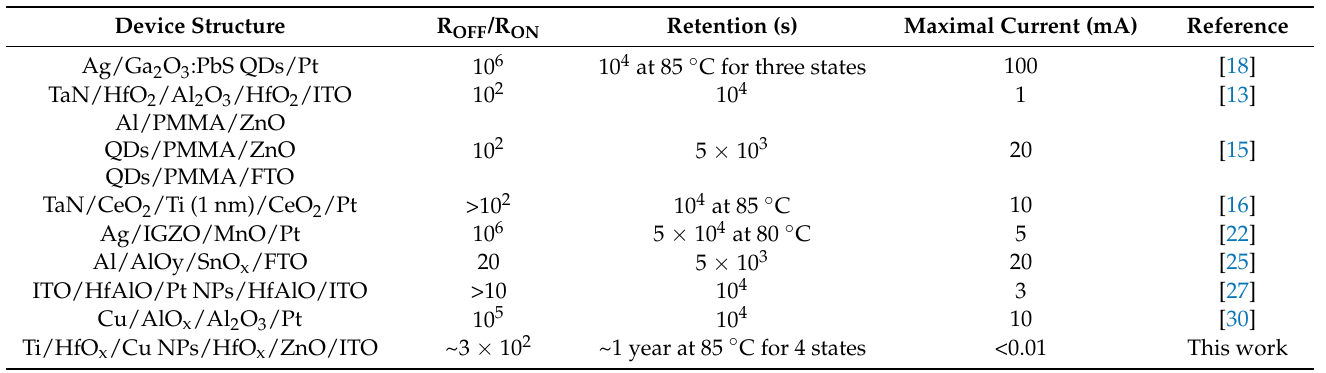
Table 3. Comparison of multilevel